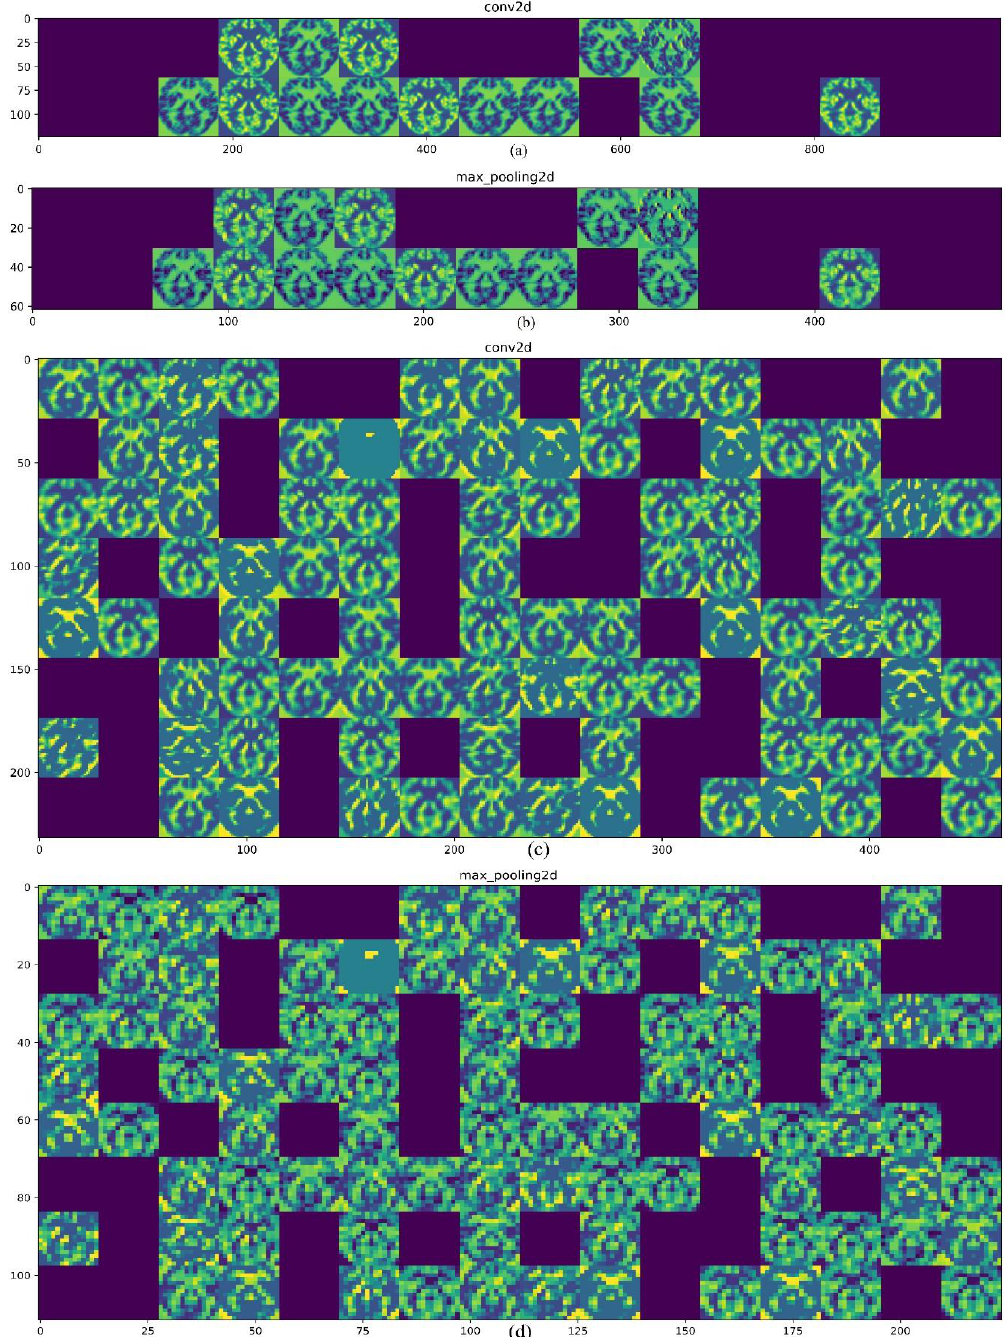
Figure 3. Illustration of the convolutional neural network (CNN) layers output. ( a ) First convolution layer output; ( b ) first max-pooling layer output; ( c ) second convolution layer output; ( d ) second max-pooling layer